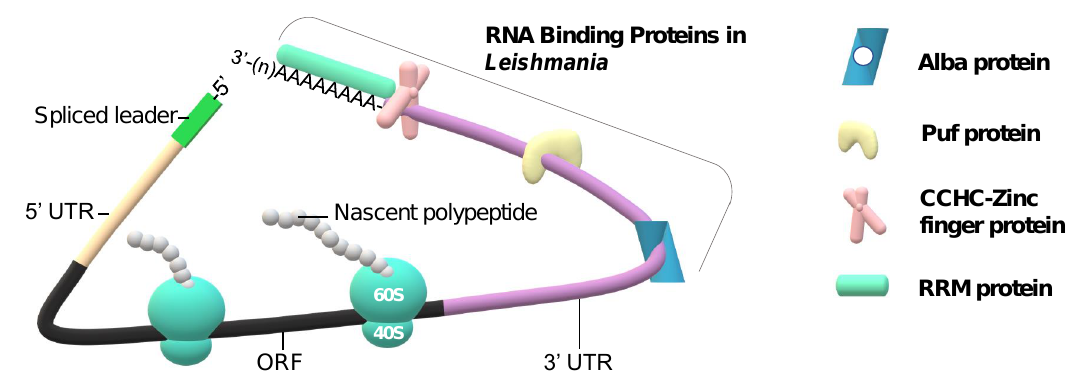
Figure 3. Schematic representation of RNA binding proteins (RBPs)’ interaction with mRNA during translation in Leishmania parasites. Leishmania RBPs are grouped in four main classes, Alba (acetylation lowers binding a ffi nity) proteins, Puf (Pumilio and Fem-3 binding factor) proteins, CCCH zinc finger proteins, and RNA-recognition motif (RRM) proteins. RRMs include proteins binding mRNAs in di ff erent part of 3 (cid:48) untranslated region (3 (cid:48) UTR) and poly(A). Poly(A)-binding protein (PABP) is shown as an example of the RRM proteins. RBPs modulate selective translation by mRNA stability, mRNA decay, polysome association, or mRNA storage process.